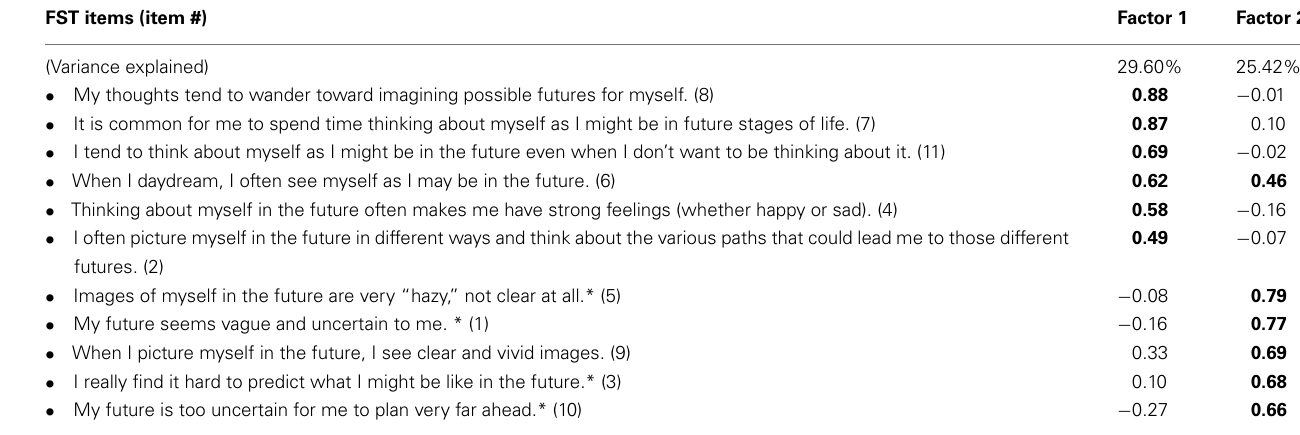
Table 3 | Pattern matrix factor loadings for the principal component analysis of the FST items ( N = 100,